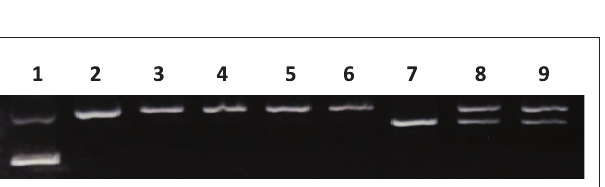
Figure 5 | Sequencing data of a g/T mismatch DNA and a g/iu mismatch DNA substrate. Upper left: G/IU DNA, template – anti-sense strand; Upper Right: T/G DNA, template – anti-sense strand; Lower left: G/IU DNA, template – sense strand.